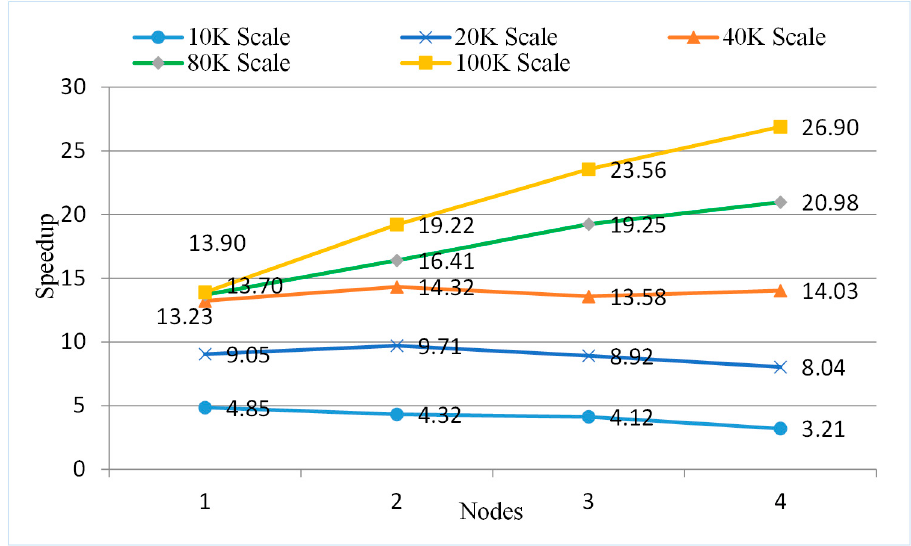
Figure 21. Achieved Speedup of the parallel algorithm at different data scales with the Mesos resource manager.